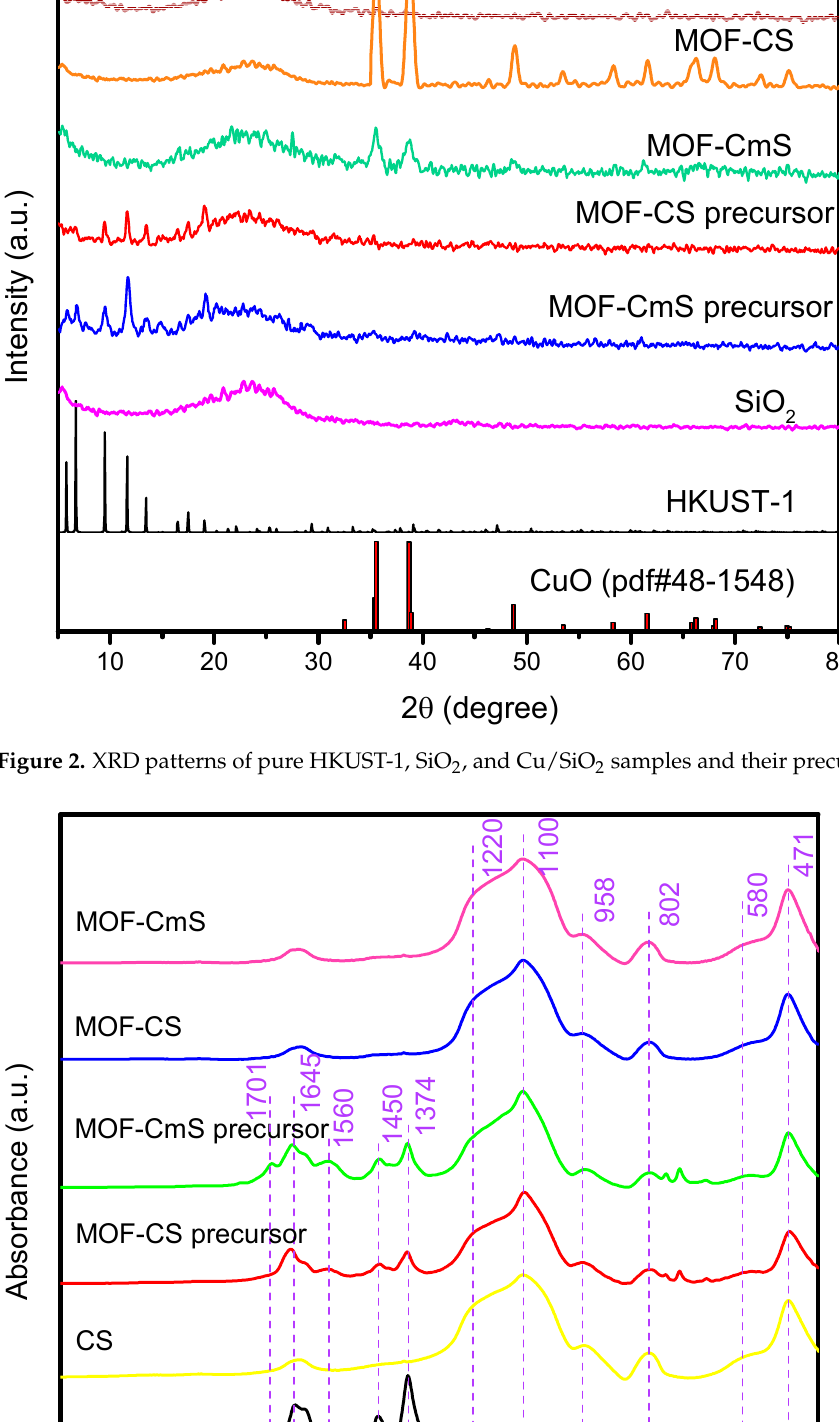
bands at 580, 500, and 460 cm − 1 due to the existence of a broad band at 471 cm − 1 [30].